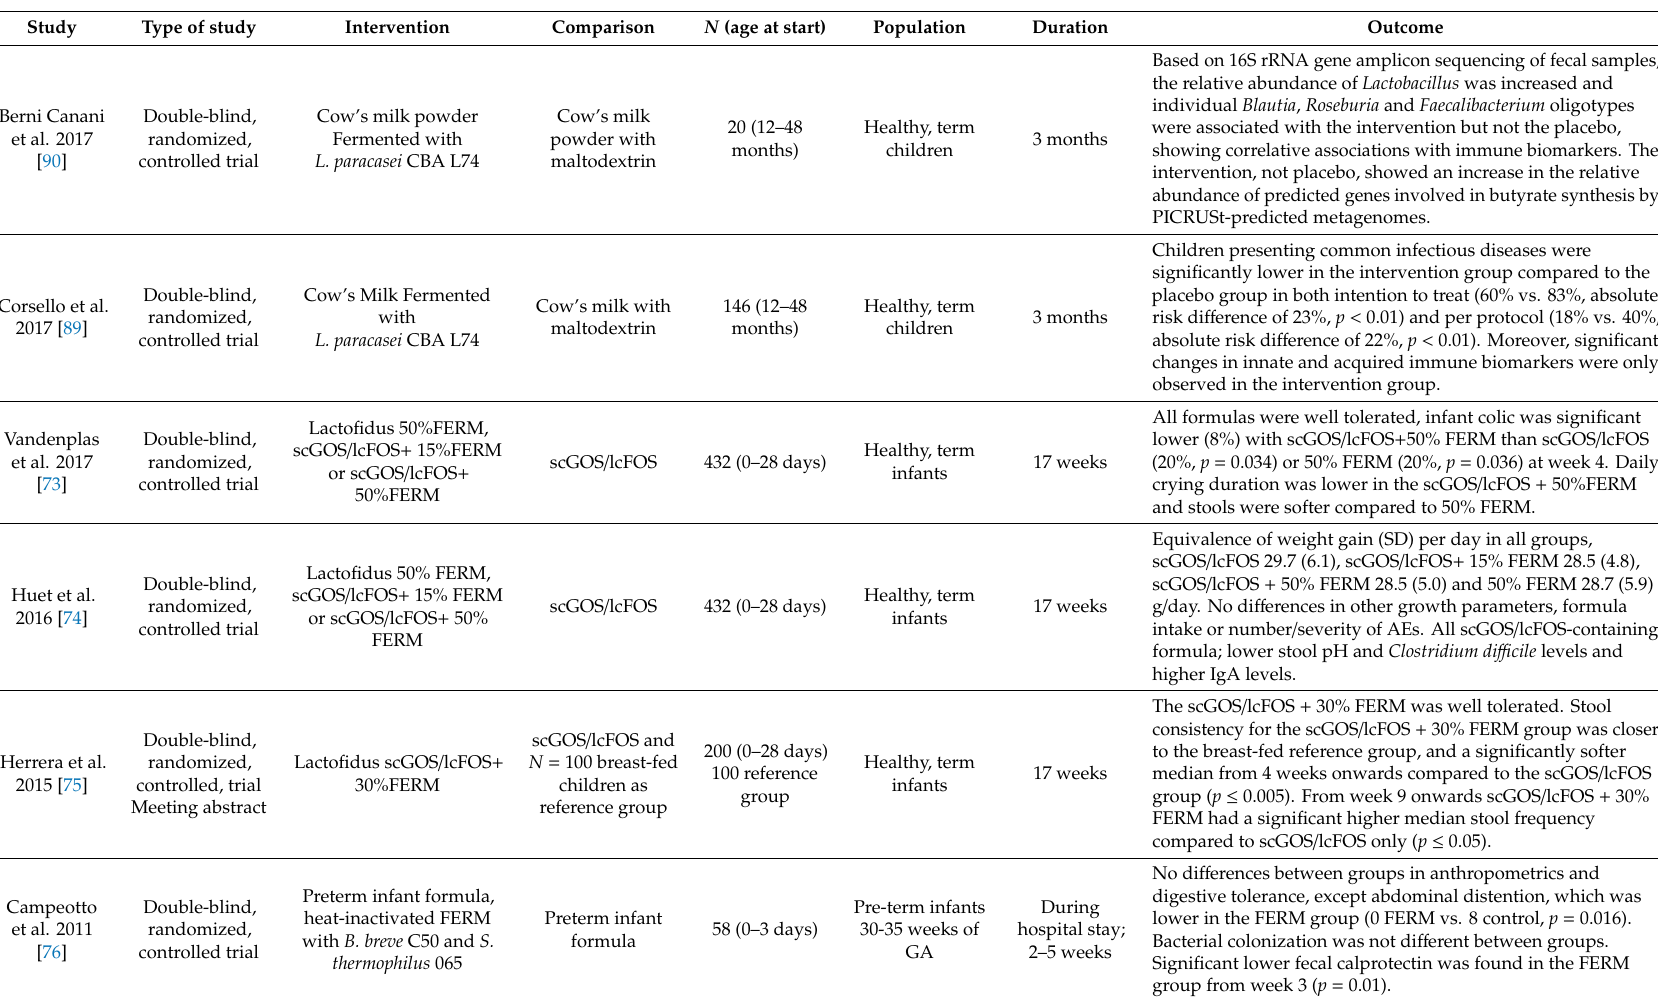
Table 1. Studies reporting interventions with postbiotics in early life, including newborns, infants and toddlers, until adulthood ( < 18